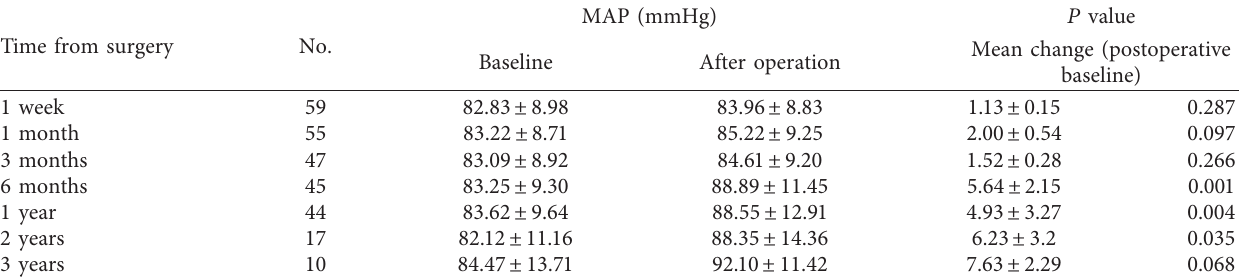
Table 3: Comparison of mean arterial pressure at baseline and postoperatively in liver cirrhosis patients. Time from surgery No.